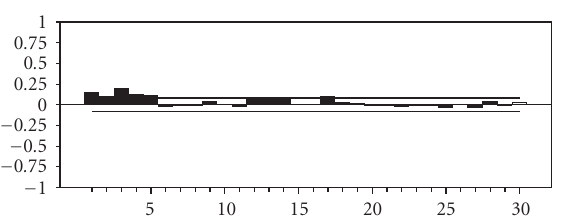
Figure 6: Autocorrelation function graph for the observed congestion duration